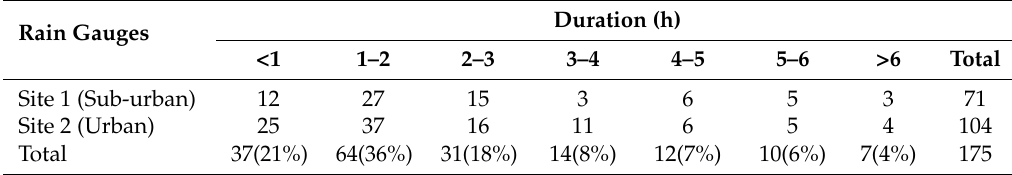
Table 1. The number of storms in different durations at two sites for the period 2008–2012. Rain